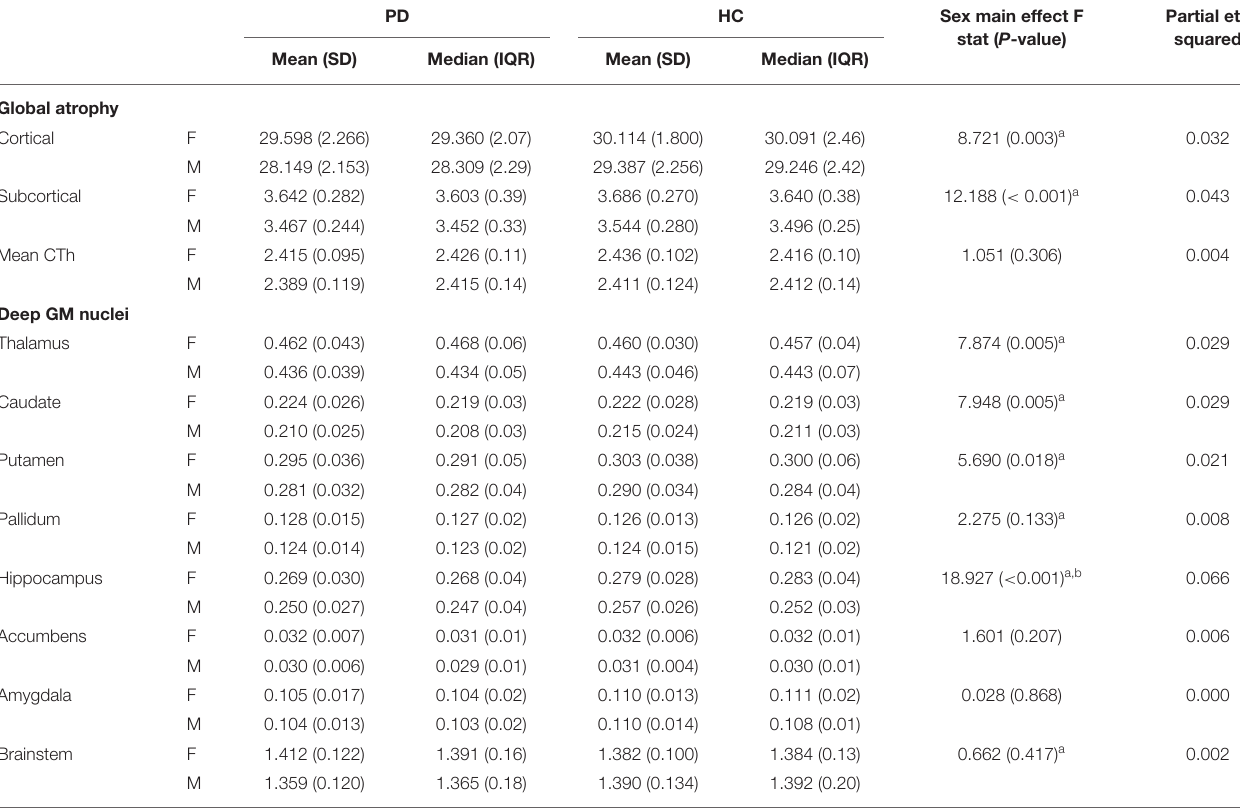
TABLE 3 | MRI-derived measures of between sex comparisons of PD and HC females and males. PD